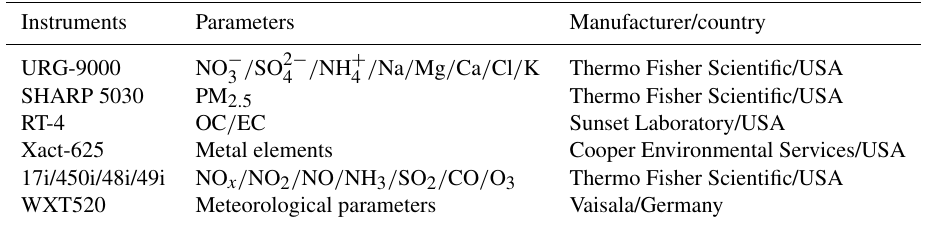
Table 1. The experimental instruments used in this study.